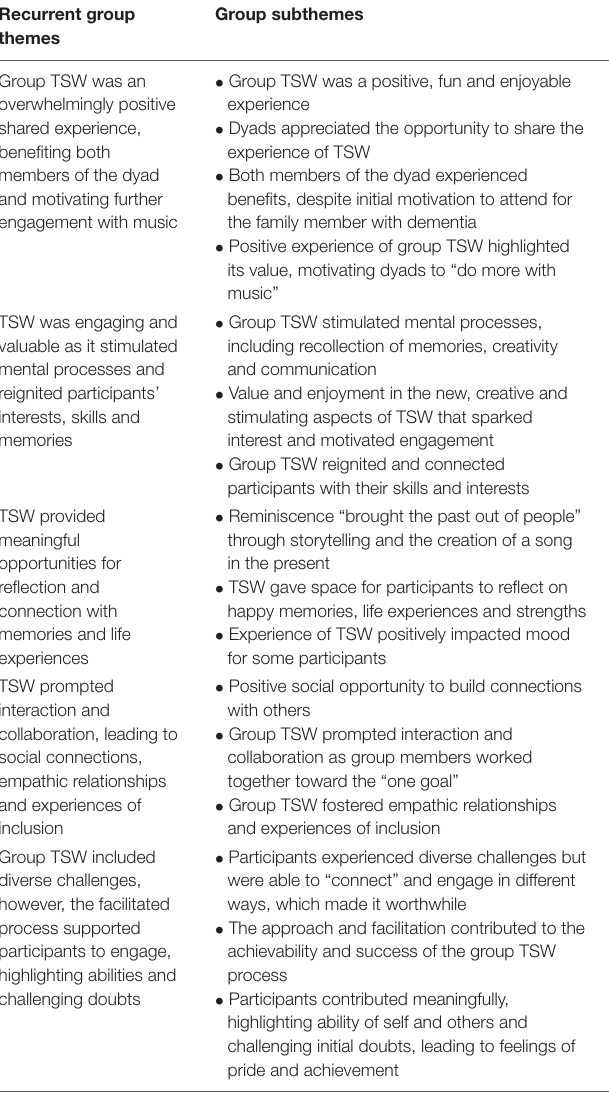
TABLE 3 | Recurrent group themes and subthemes from cross-case analysis of interview